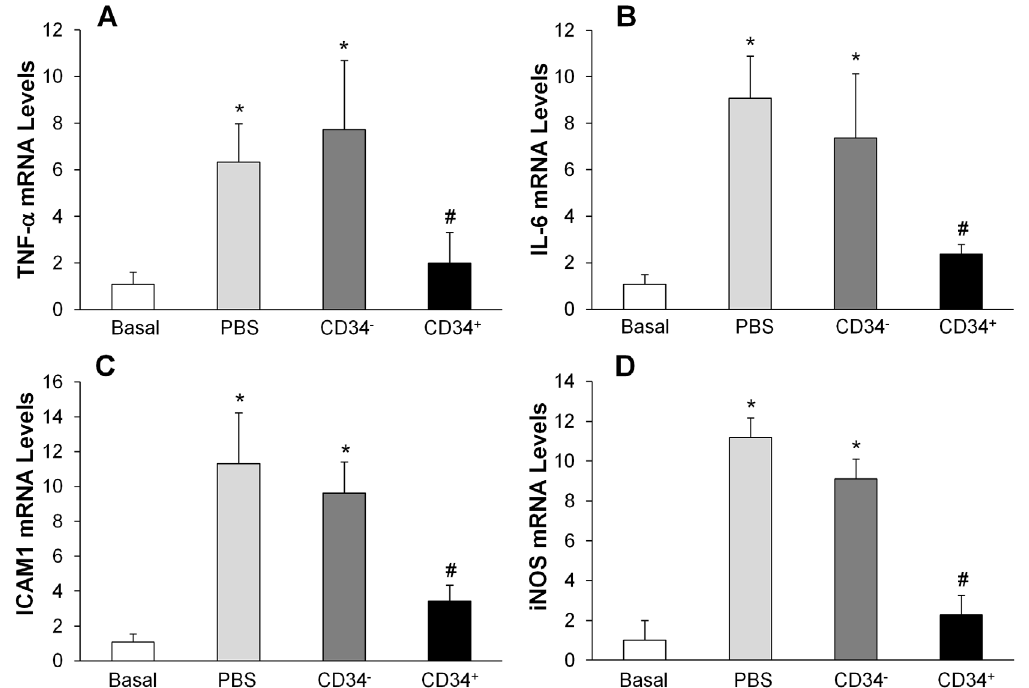
Figure 4. QRT-PCR analysis of expression of pro-inflammatory mediators in mouse lungs following LPS challenge. Lung tissues were collected at 26 h post-LPS challenge for RNA isolation and QRT-PCR analysis. Data are expressed as mean 6 SD ( n =4/group). *, P , 0.001 versus Basal; # , P , 0.05 versus PBS or CD34 2 .